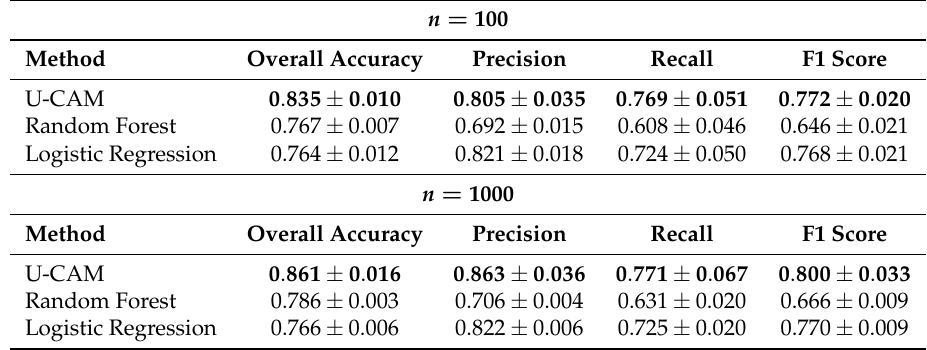
Figure 8. Six examples of ( a ) Landsat composite images, ( b ) their corresponding CDL labels, ( c ) segmentation predictions by models trained on sparse pixel labels, and ( d ) segmentation predictions by models trained on image labels. Yellow pixels are predicted to be cropland, and purple pixels are predicted to be non-cropland. Panel ( d ) shows the class activation map (CAM) extracted from the U-CAM model; yellow corresponds to high cropland activation and dark blue corresponds to low cropland activation. All models were trained on 1000 labels, and predictions are shown for samples in the test set. Table 3. Test set accuracy, precision, recall, and F1 scores for the U-CAM and baselines trained on image labels at training set size n = 100 and n = 1000. Bolded numbers display the highest value in each